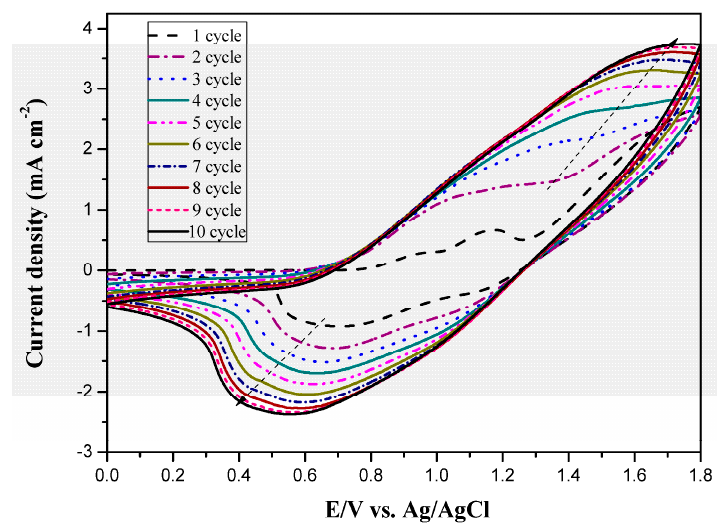
Figure 3. Electrochemical synthesis of PtCz in acetonitrile (ACN)/dichloromethane (DCM) (1:3, by volume) solution at 100 mV ∙ s − 1 on indium tin oxide (ITO) working electrode.